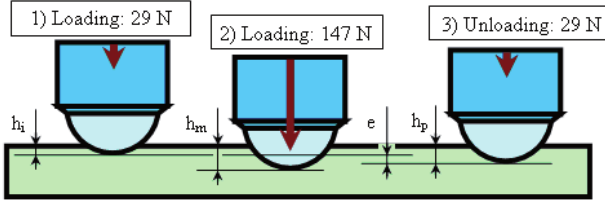
Fig. 4. Multi-step